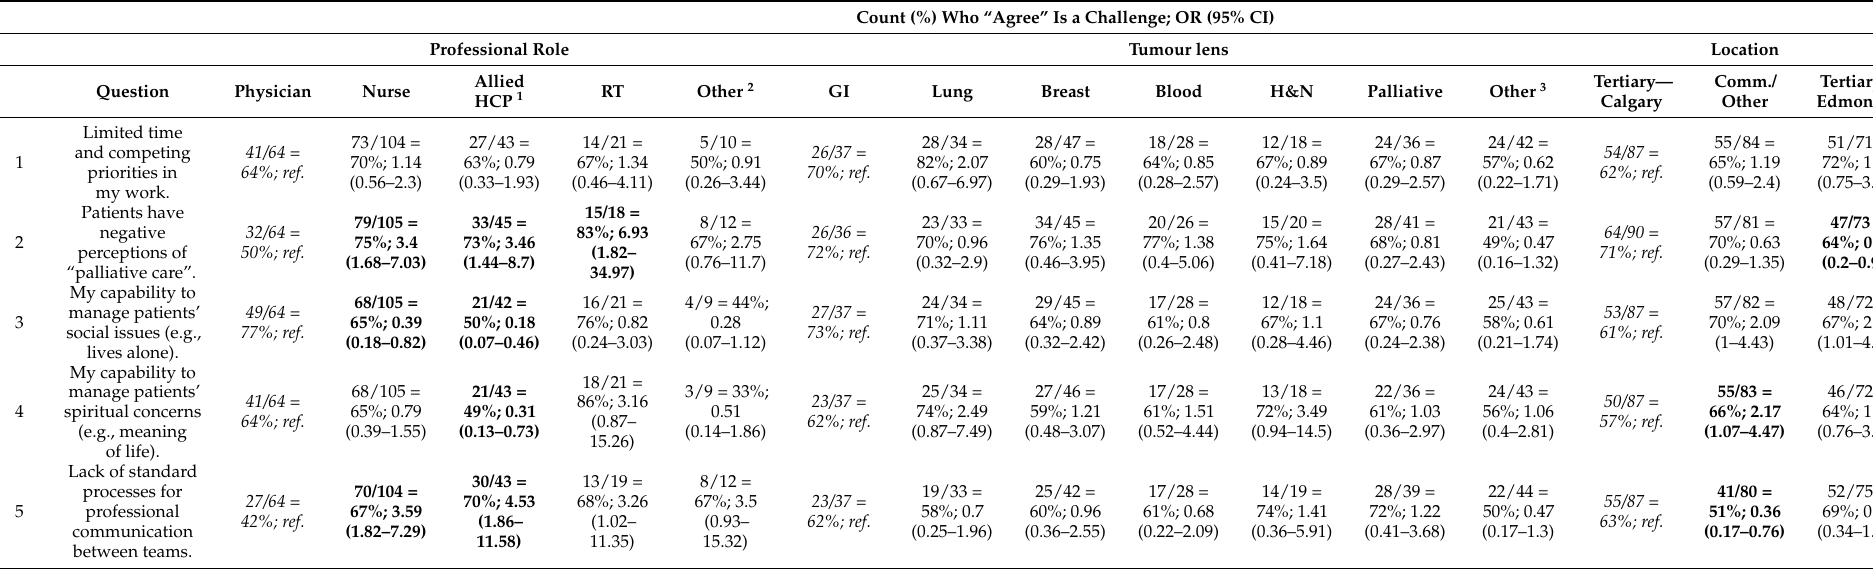
Table 2. Factors (professional role, tumour lens, and work location) associated with survey respondents identifying aspects of earlier use of palliative care as being “challenging” to them, for the five most frequently identified